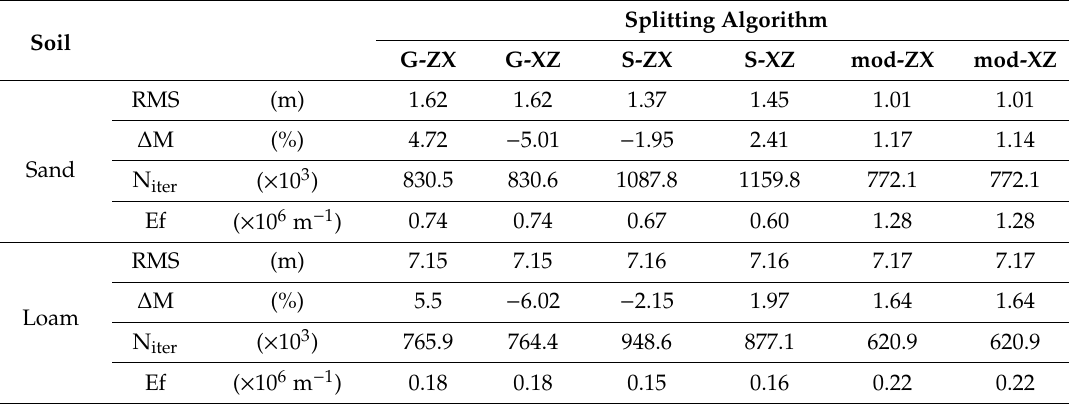
Figure 10. Wetting front calculated after time T using the splitting algorithm (sequence ZX, η = 0.5, N min = 4, N max = 8) with the Mualem–van Genuchten function: ( a ) sand, T = 2 h and ( b ) loam, T = 35 h. The dotted line represents the analytical solution, the red line represents the Godunov method, the blue line represents the standard Strang method, and the green line represents the alternate method. Table 2. Root mean square (RMS) error, mass balance error ∆ M , number of iterations N iter , and e ffi ciency E f for the solution after time T obtained using various splitting algorithms (G—Godunov method; S—Strang method; mod—alternate method; ZX and XZ—sequences of splitting in z and x direction,